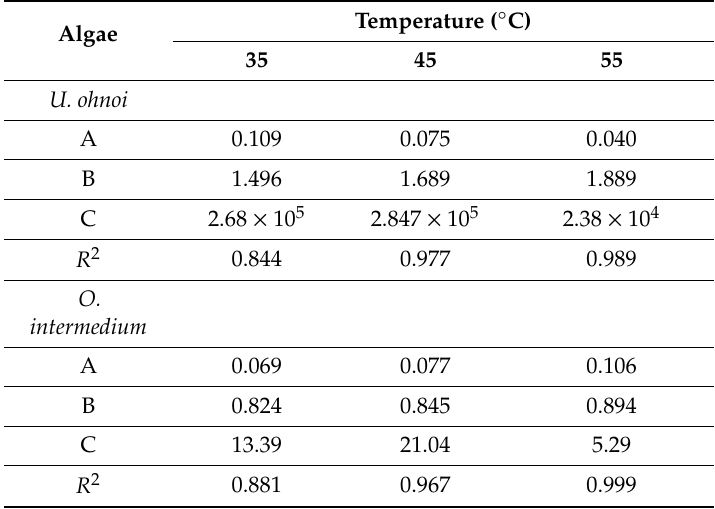
Table 1. Guggenheim–Anderson–de Boer (GAB) model coe ffi cients and